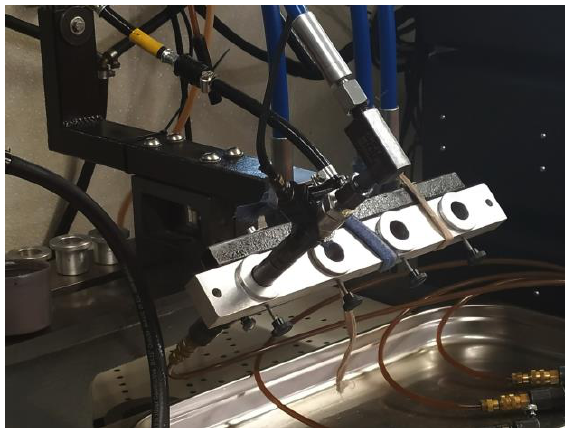
Fig. 6. View of the fuel injector during flow measurements